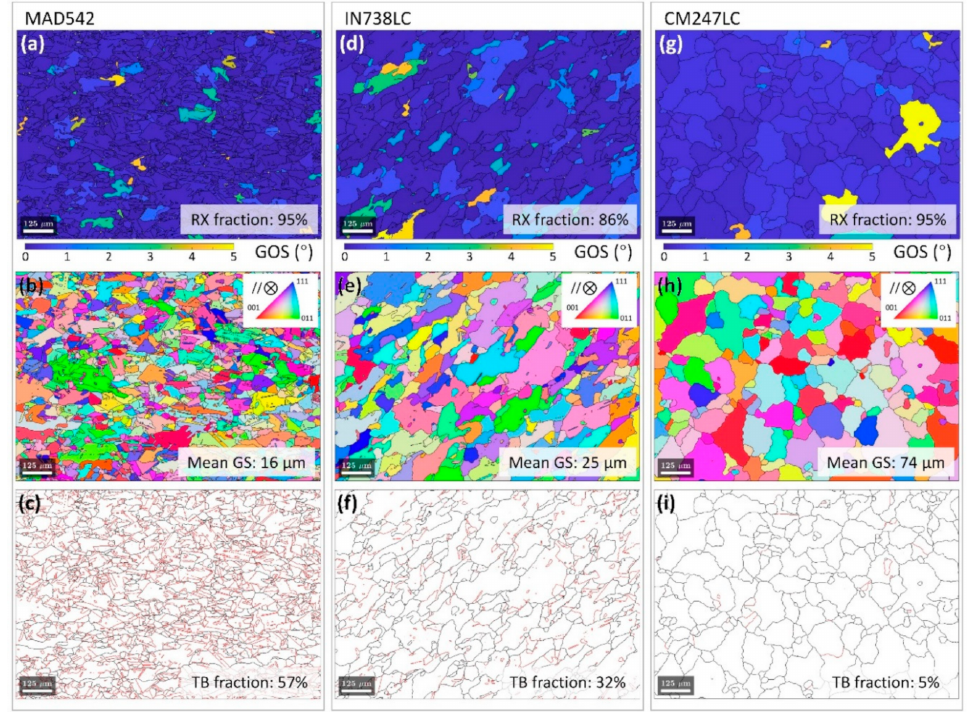
Figure 3. Post-processing heat treated microstructures of LPBF MAD542 ( a ) grain orientation spread (GOS) map, ( b ) inverse pole figure (IPF) coloring map, ( c ) grain- and twin-boundary map; LPBF IN738LC [34] ( d ) grain orientation spread (GOS) map, ( e ) inverse pole figure (IPF) coloring map, ( f ) grain- and twin-boundary map; LPBF CM247LC ( g ) grain orientation spread (GOS) map, ( h ) inverse pole figure (IPF) coloring map, ( i ) grain- and twin-boundary map. Electron backscatter di ff raction (EBSD) step size: 2 µ